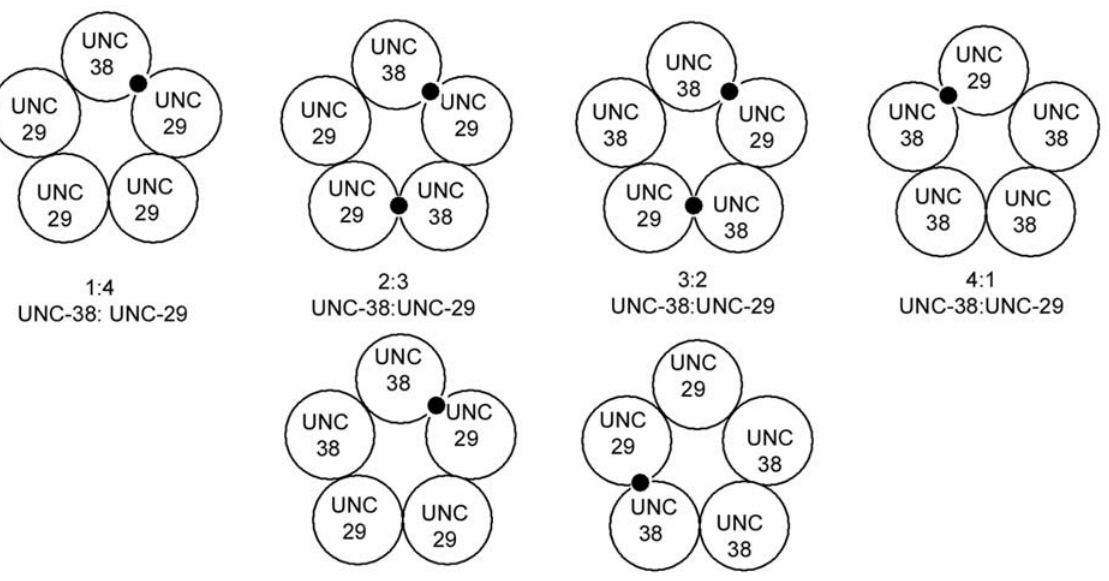
Figure 6. Possible combinations of the two subunits in the oocyte membrane. The possible combination of Asu-UNC-38 and Asu-UNC-29 that might be present in the injected oocytes are shown. Agonist binding sites, which, by analogy with mammalian receptors should be at an interface between the two subunits, [38] are indicated by black circles. The Figure is based on a similar discussion for mammalian receptors [32].